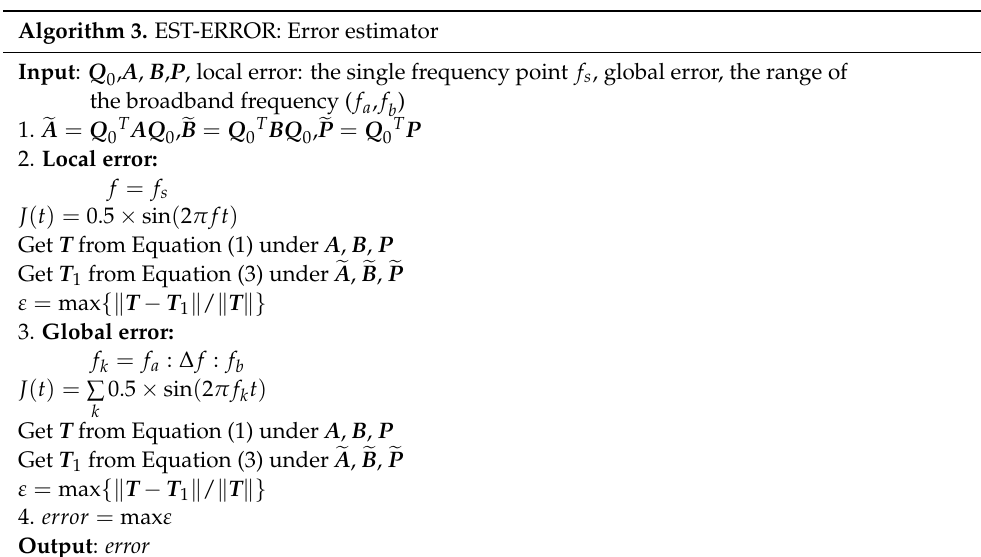
Algorithm 3. EST-ERROR: Error